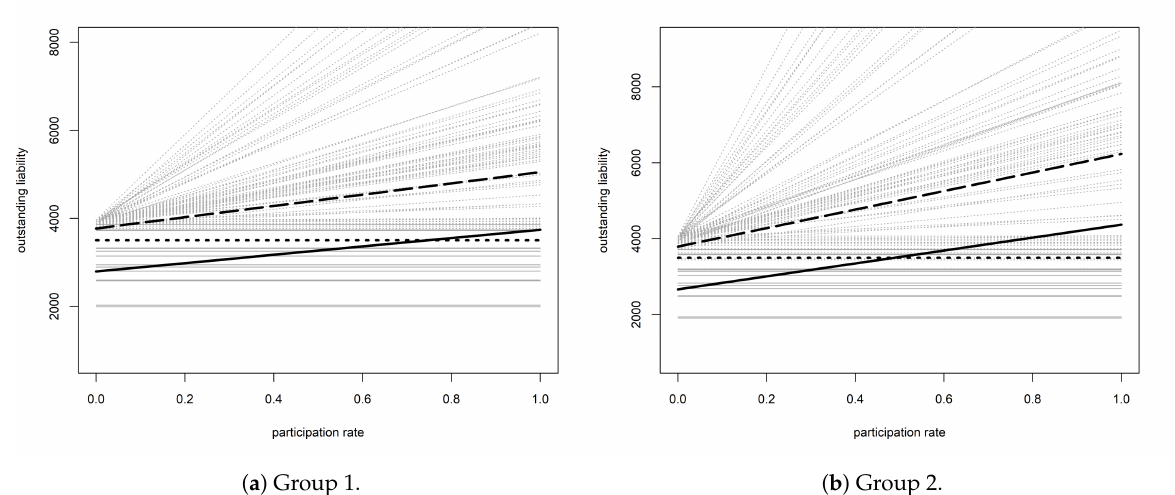
Figure 2. Case 2: 100 scenarios of the outstanding liability in terms of the participation rate when E Q [ ∆ ] = 0.8 (grey dotted if no default at maturity T 1 , grey otherwise). Additionally, the mean (black dashed) and discounted mean (black) of the outstanding liability, and the premium (black dotted) are